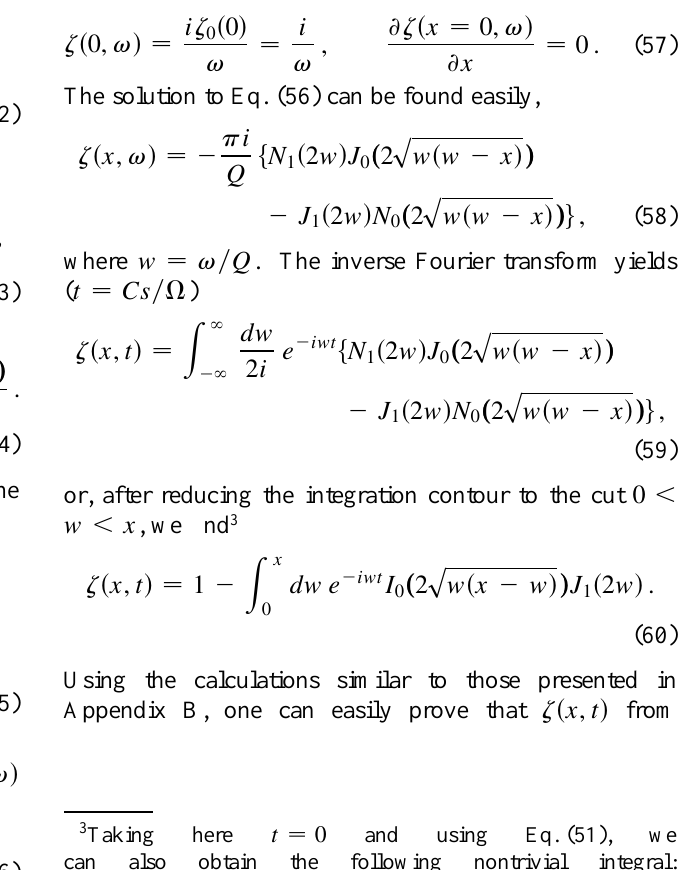
FIG. 6. Dependences of the (dimensionless) amplitude j z j on the time ( (cid:67)(cid:115) (cid:121) V ). The total phase advance of the ion oscillations along the beam is (cid:76) V (cid:173) (cid:50)(cid:48) , from top to bottom with the border